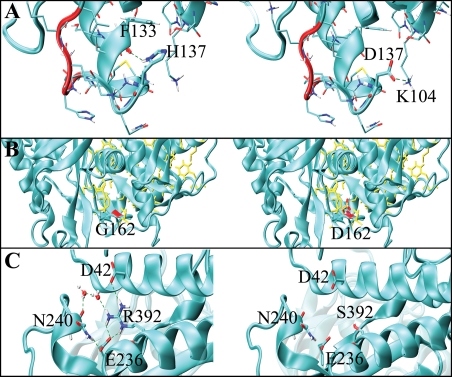
Structural features of mutations p.His137Asp, p.Arg392Ser and p.Gly162Asp GCK.The structure of GCK in the closed form (PDB code:1v4s) is shown as cyan ribbons. A) p.His137Asp. Loop 141–144, which is involved in GKRP binding, is in red. His137 is at the end of the α3 helix. His137 is a capping residue of the helix, which is terminated by the interaction between side chain of His137 and Phe133. Asp137 (right) is not able to replace His137 interactions but adds a new interaction with Lys104. B) p.Gly162Asp. Yellow sticks represent hydrophobic residues that constitute the core. The location of Gly162 is marked in red (left of the panel). Asp162 is on the right of the panel. C) p.Arg392Ser. Residues Asp42, Glu236, Asn240 and Arg392 are represented by yellow sticks. H-bonds are shown in green. The wild-type enzyme and the p.Arg392Ser mutant are on the left and right of the panel, respectively.